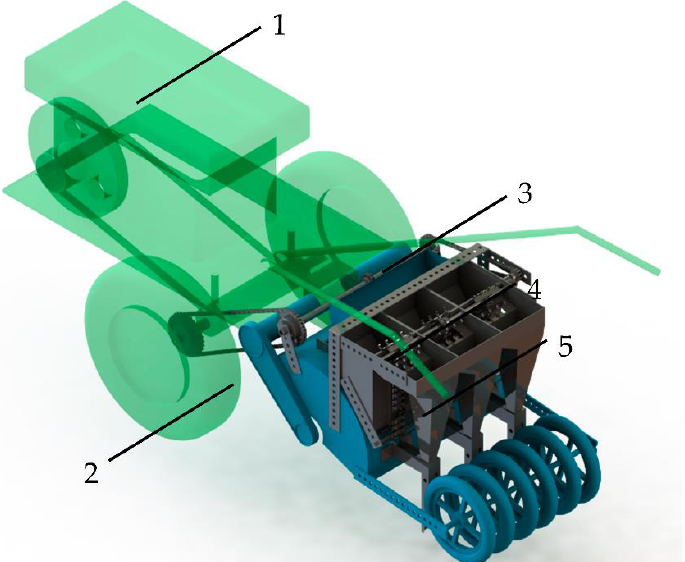
Figure 2. CAD model of the onion transplanter, as attached to a 2WT and PTOS. ( 1 ) 2WT; ( 2 ) PTOS; ( 3 ) Dispensing subsystem; ( 4 ) Orienting subsystem; ( 5 ) Planting subsystem. This model was designed using SolidWorks Student Edition 2021.